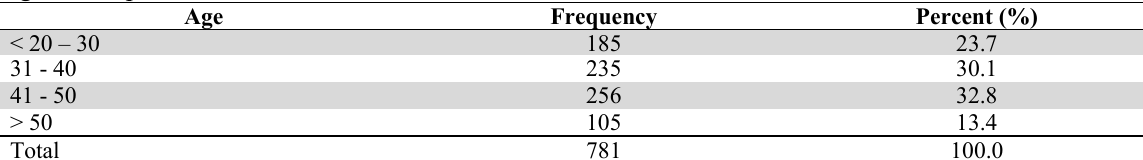
Age of Respondents Age Frequency